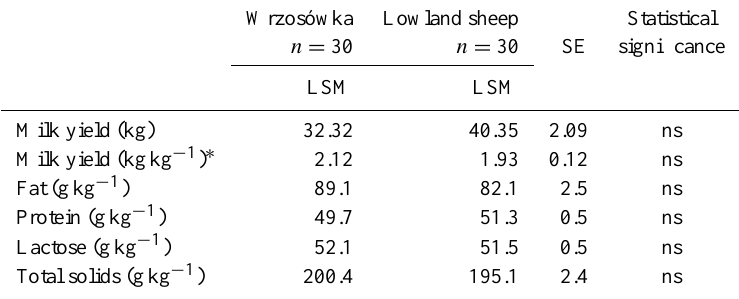
Table 3. Milk yield and the amount of basic components in examined sheep breeds. Wrzosówka Lowland